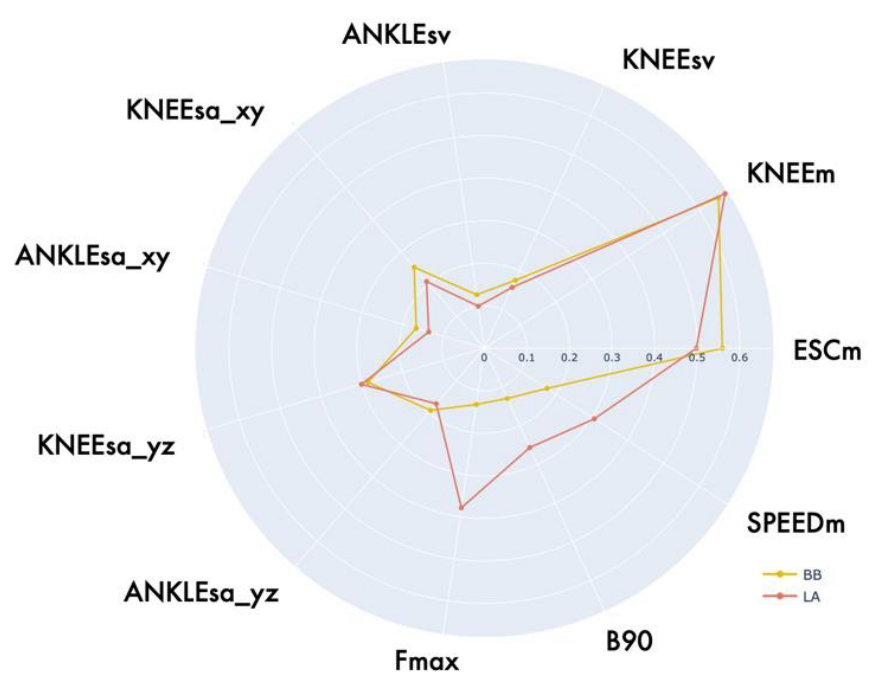
Figure 8. Radar chart comparison between functional parameters estimated during LA and BB executions for PD group.